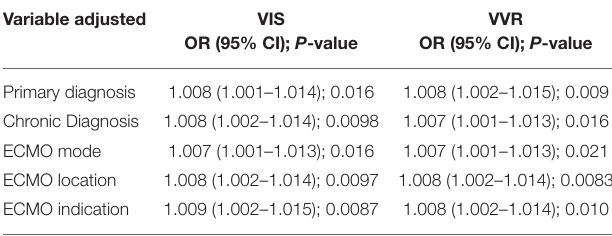
TABLE 4 | Bivariable analysis of association of vasoactive-inotropic score (VIS) and vasoactive-ventilation-renal score (VVR) with mortality. Variable